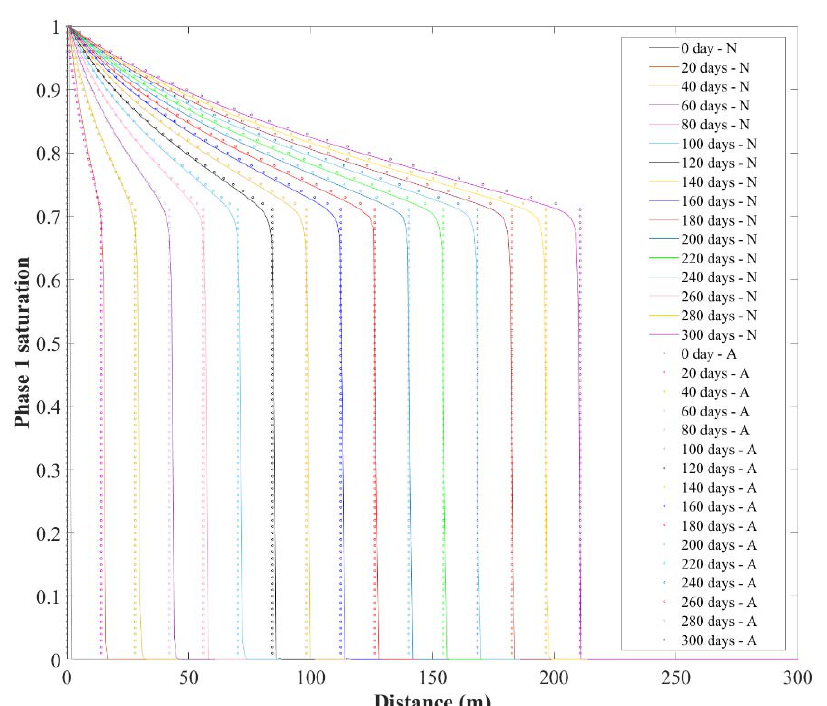
Figure 2. Comparison of flood front curve between the numerical model and analytical model over 300 days: N represents numerical calculation results; A represents analytical calculation results.